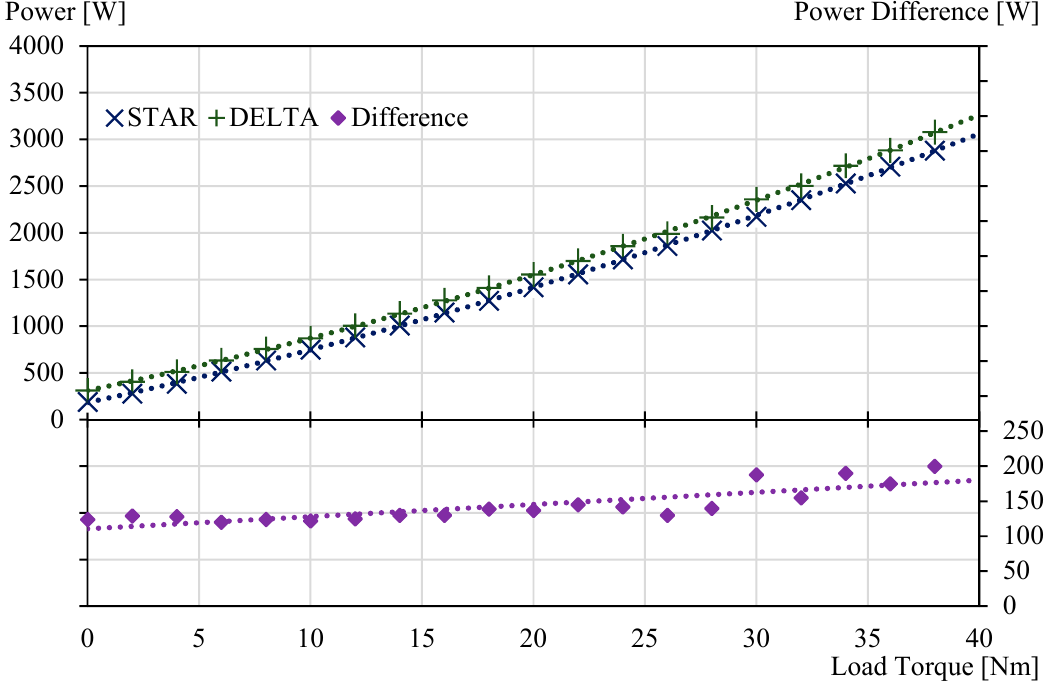
Figure 12. Consumed electric power for a star and delta; reference speed 500 RPM, reference stator flux 1.7 Wb.